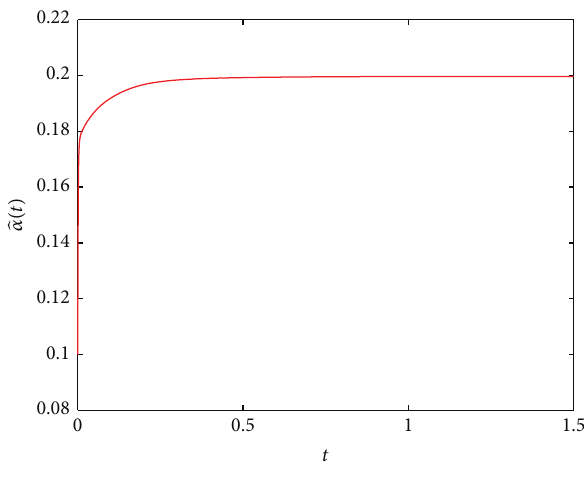
Figure 6: Response curve of the estimation of 𝛼 ∗ .